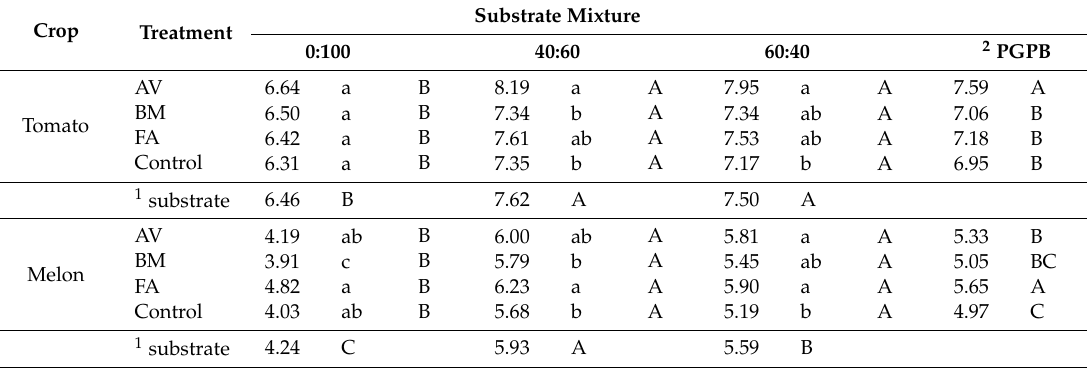
Table 4. Yield (kg m − 2 ) for both crops (tomato and melon) in containers according to the bacteria and substrate mixture (VC:CF % v : v